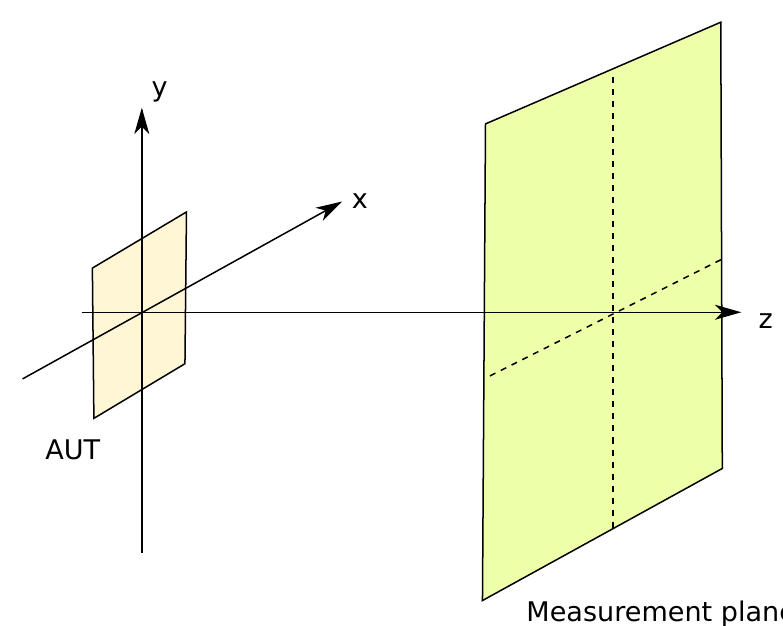
Figure 1. Geometry of a planar measurement